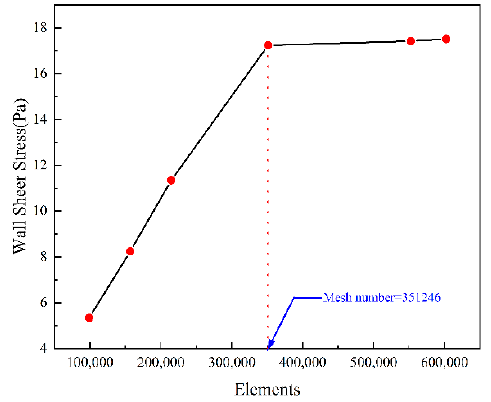
Figure 3. Grid independence verification.